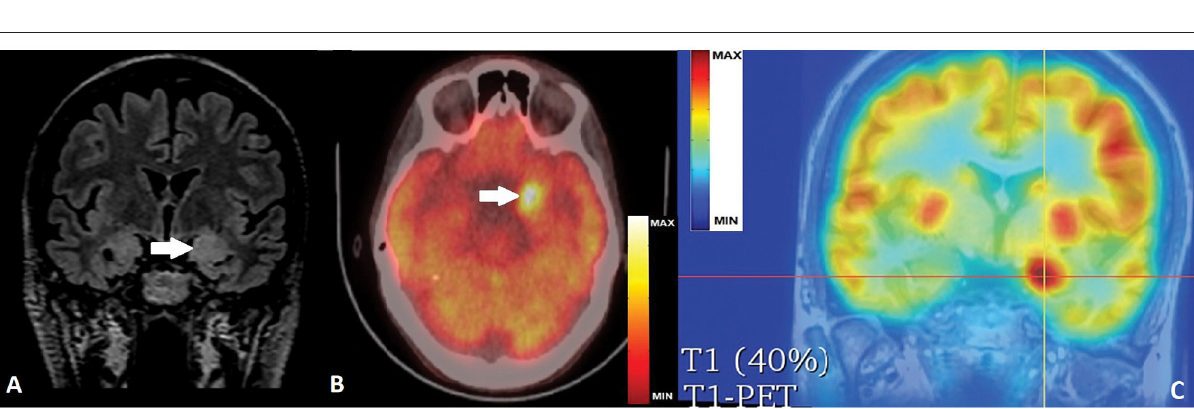
FIGURE 2 | (A) Coronal FLAIR MRI with bi-mesiotemporal hyperintensity, more prominent on the left, with increased volume of left amygdala (white arrow). (B) Axial PET-CT scan with hypermetabolic left mesiotemporal spot(white arrow). (C) PET-T1 MRI co-registration with clear hyperactivity in the left amygdala (crossed lines’